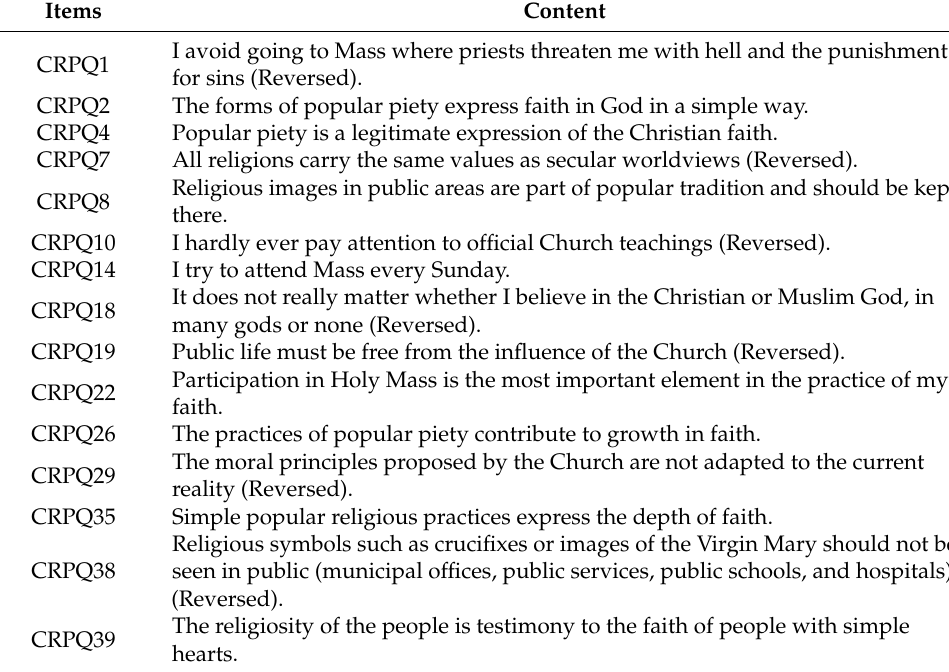
Table 1. Item pool of 15 after expert evaluation (Sample